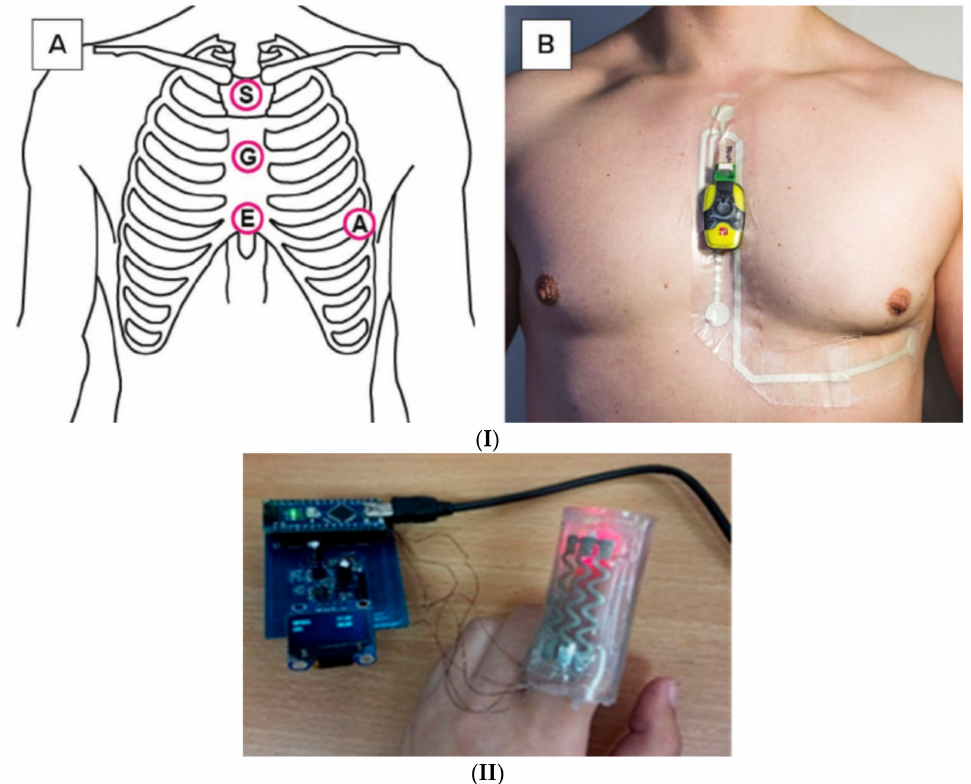
Figure 6. Printed heart rate and oxygen saturation sensors. ( I ) shows the screen-printed ECG sensor on TPU film; the left figure shows the placement of the 4 electrodes, while the figure on the right shows a volunteer wearing the device; reused with permission from [279], Copyright (2019), John Wiley & Sons. ( II ) shows the inkjet-printed pulse oximeter while performing live monitoring on a human subject [188], used under the terms of Creative Common CC BY